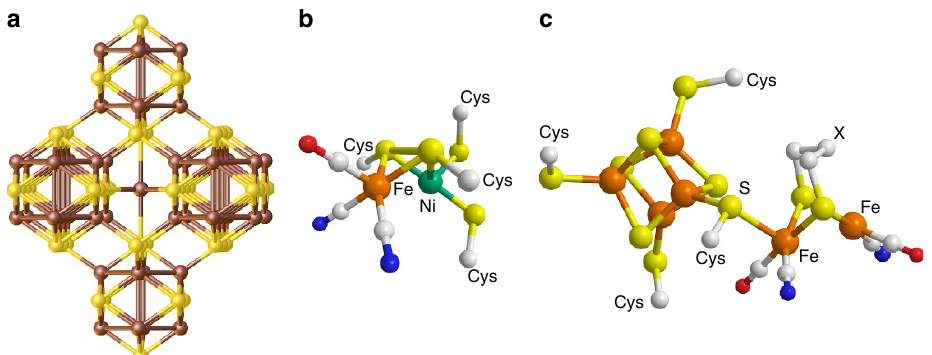
Figure 1 | Structural comparison of penlandite with hydrogenases. ( a ) Crystal structure of Ni 4.5 Fe 4.5 S 8 . The nickel and iron sites (brown) share the same positions within the crystal and are bridged by sulfur (yellow). ( b ) Active site of the [FeNi]-hydrogenase (PDB: 4U9H) as well as ( c ) [FeFe]-hydrogenase (X ¼ NH, PDB: